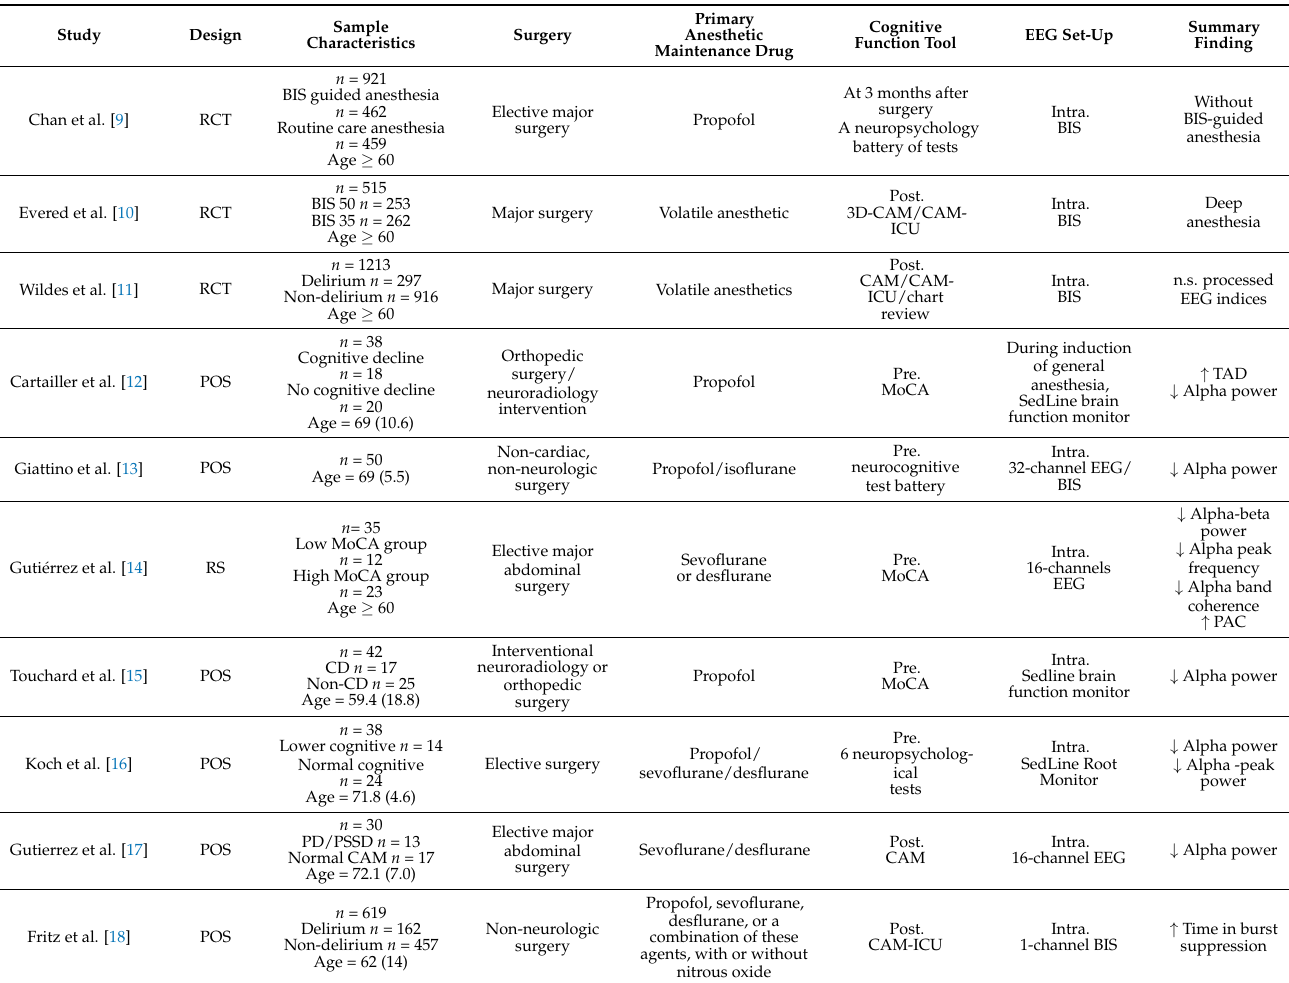
Table 1. Studies about intraoperative EEG features related to